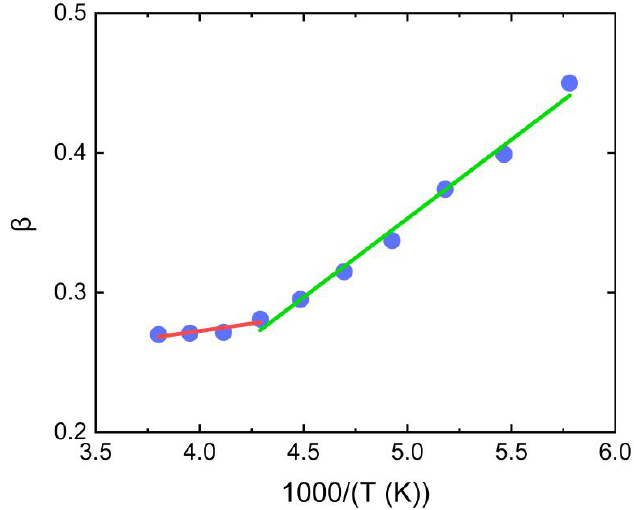
Figure 5. Schematic representation of the correlation between temperature and β . The β of γ 1 relaxation of disordered side chains follows lower temperature dependence (green line), and the β of γ 2 relaxation of disordered side chains follows higher temperature (red line).